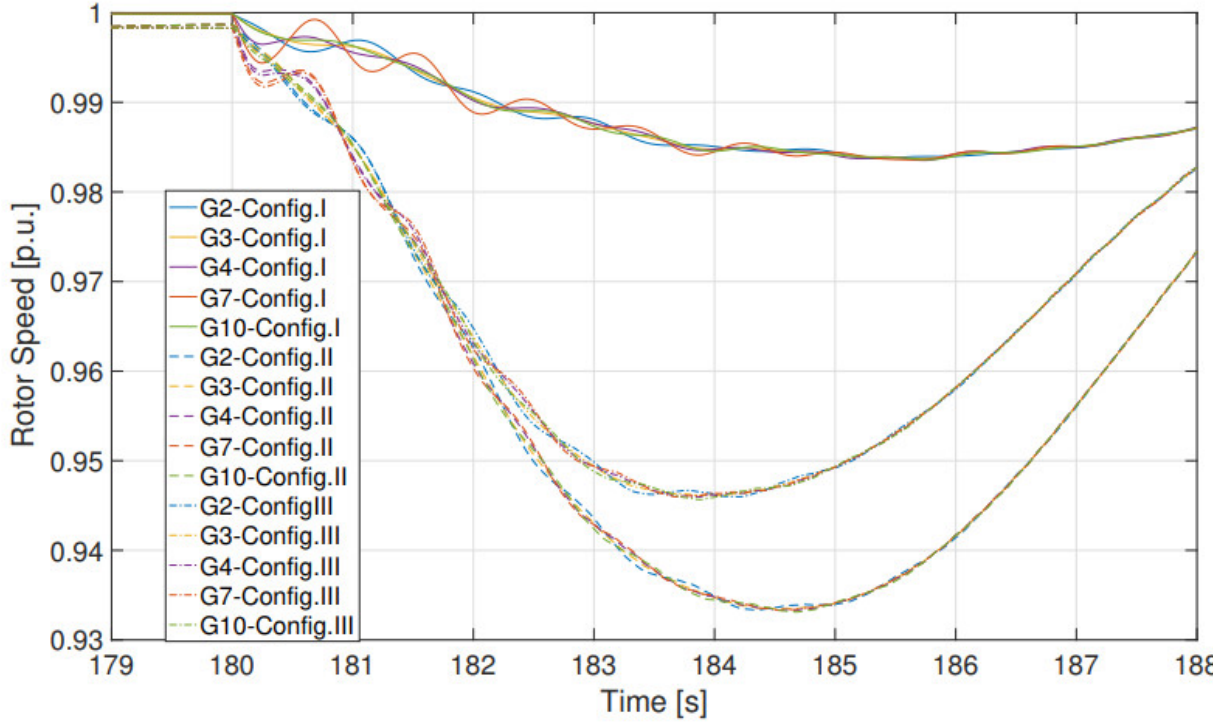
Figure 15. IEE bus 39 rotor speed vs. time.